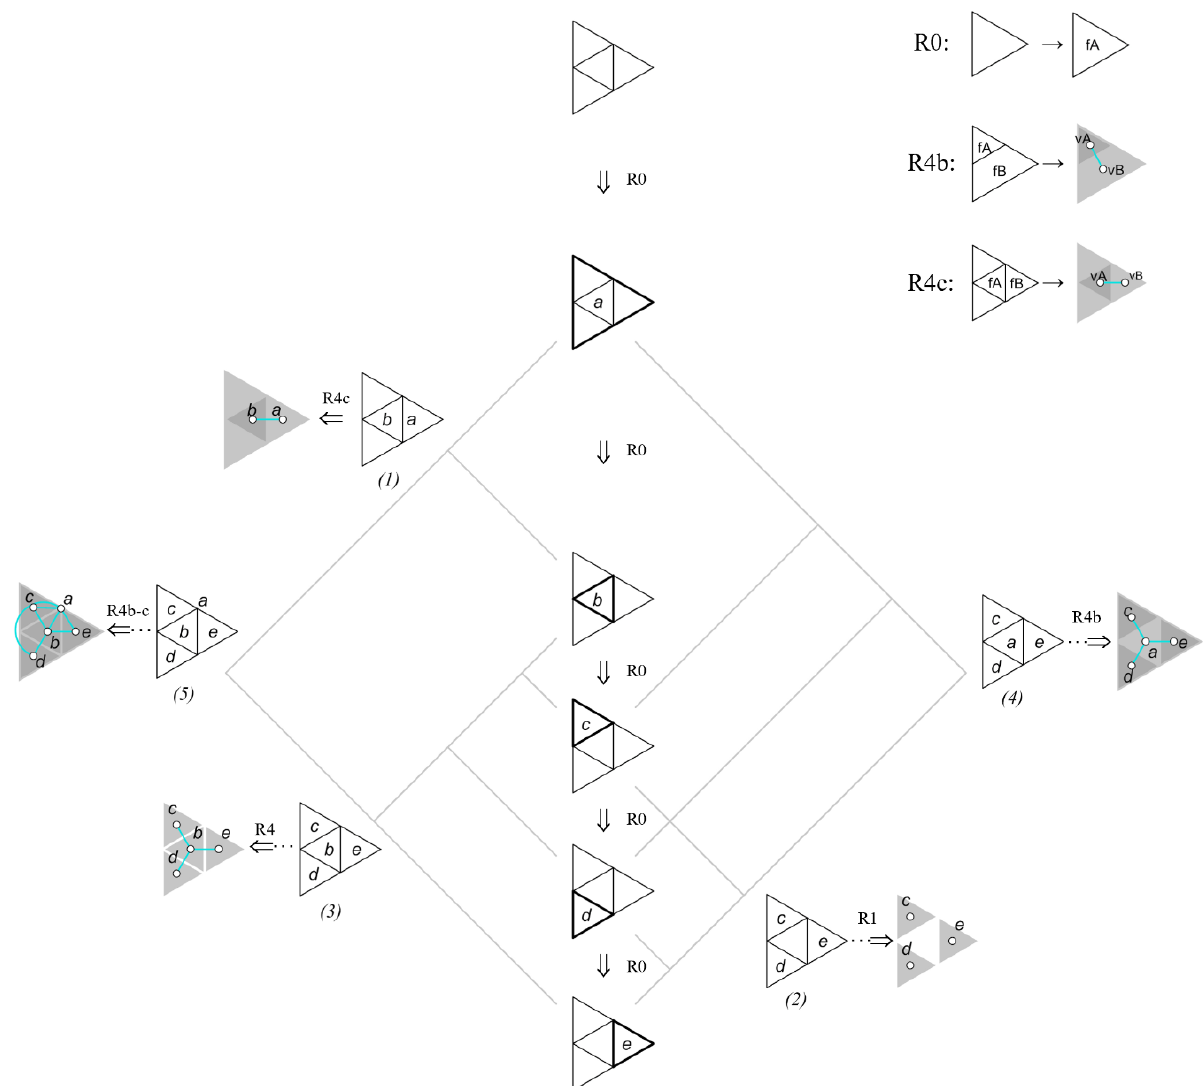
Figure 2. Different graphs are derived from one shape by decomposition.